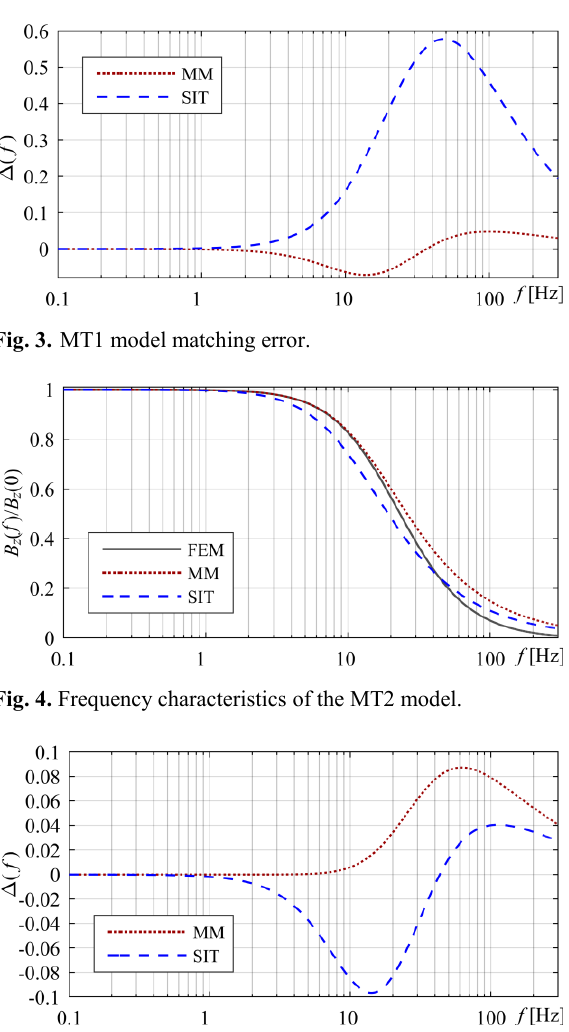
Fig. 2. Frequency characteristics of the MT1 model.